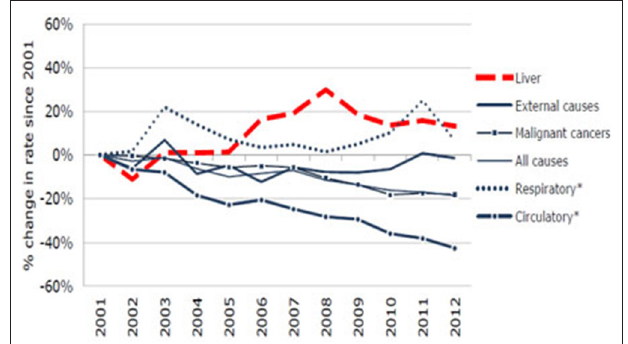
FIGURE 1 | Statistical representation of mortality (in percentage) from various diseases in human (Finkelstein et al., 2012). FIGURE 2 | Occurrence and prevalence of various liver diseases